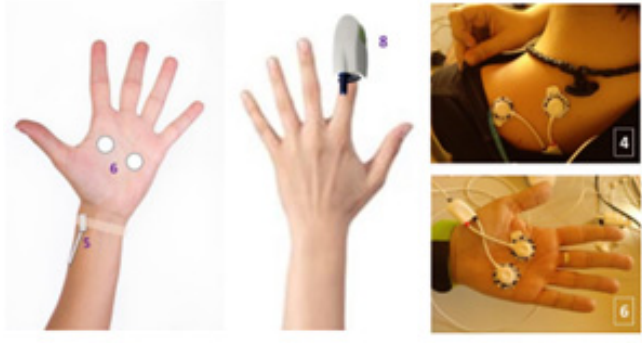
cording to what she was feeling at that moment. Just after finishing each video a blood